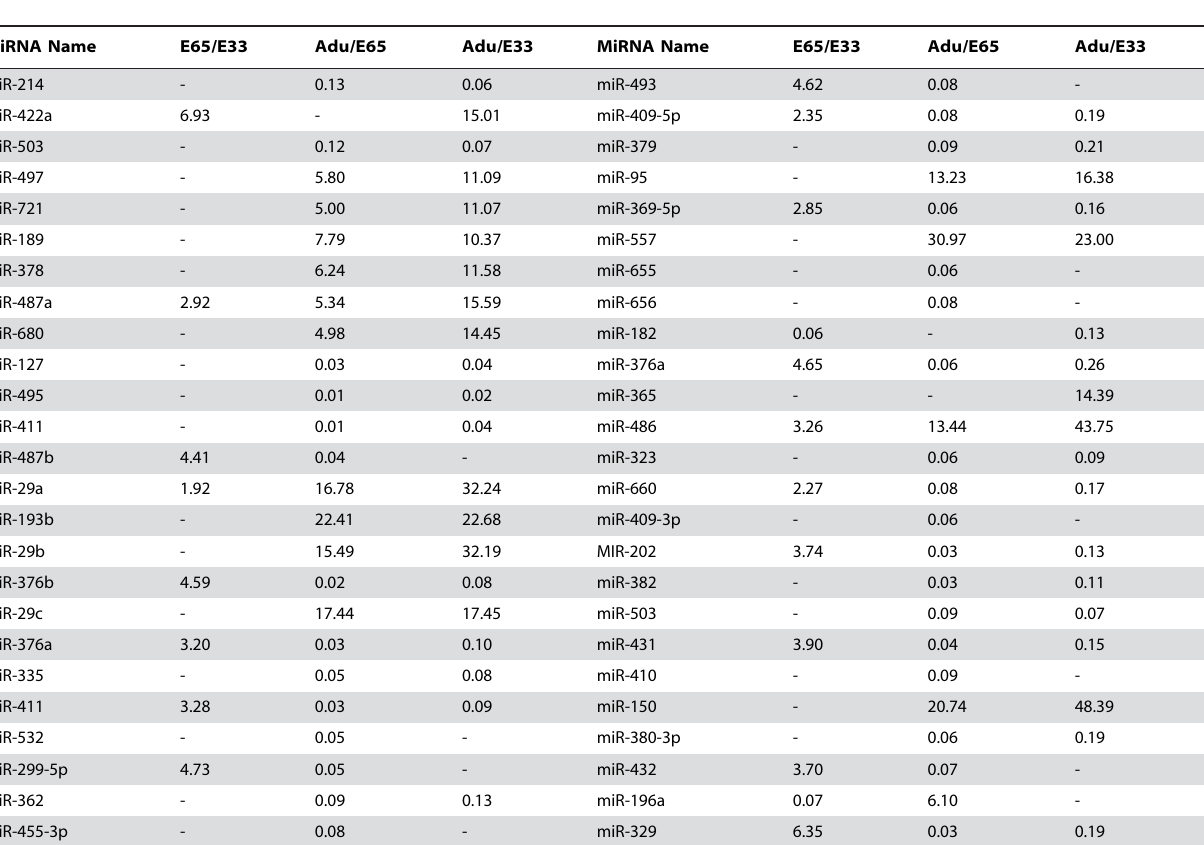
Table 2. MiRNAs differentially expressed between E33, E65 and Adu stages (Fold change . 10.0, p , 0.001 and FDR , 0.001).